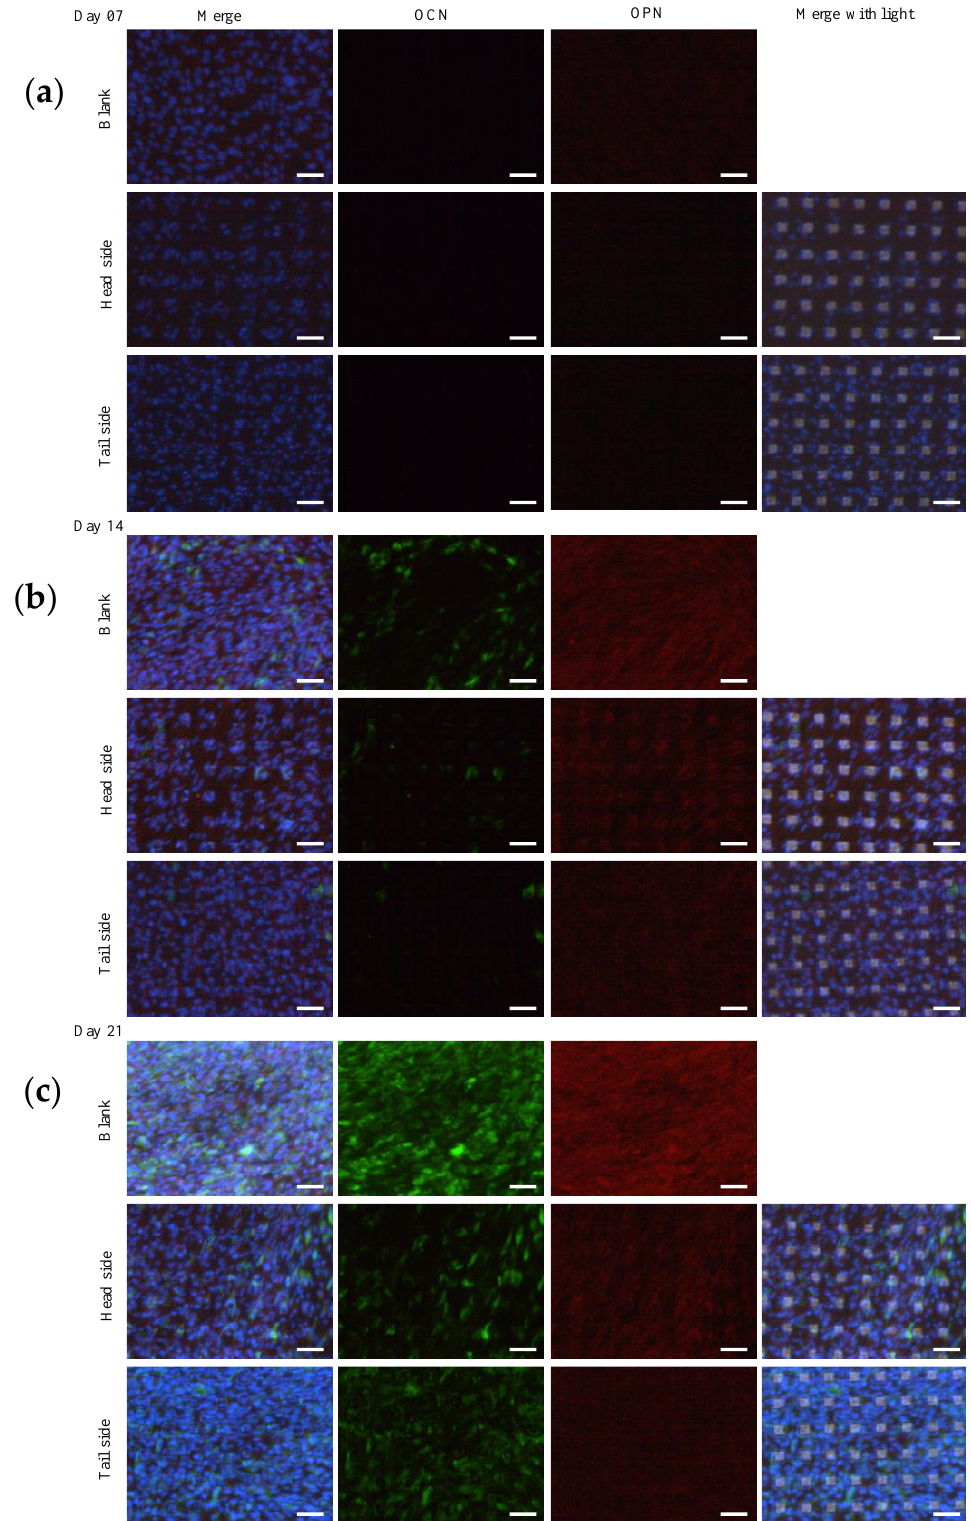
Figure 9. Immunofluorescence images of Ti surface-related OCN and OPN expression in MC3T3-E1 cells. Cells were incubated in α -MEM (5% FBS) with an osteogenic supplement for 7, 14 and 21 days. Nuclei, OCN and OPN were visualized by staining with DAPI (blue), Alexa Fluor ® 488 (green) and Alexa Fluor ® 555 (red). Scale bars represent 100 µ m. ( a – c ) were for 7, 14, and 21 days respectively.